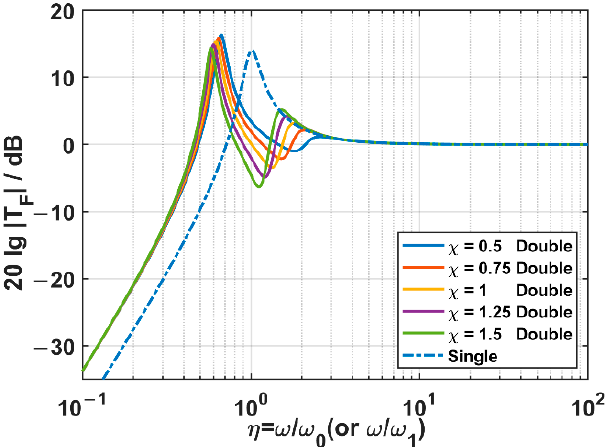
Figure 10. The acceleration response spectra of two suspension systems in mass ratio cases. Among them, the dashed line is the result of the OSSS, while the solid lines are those of the TSSS.